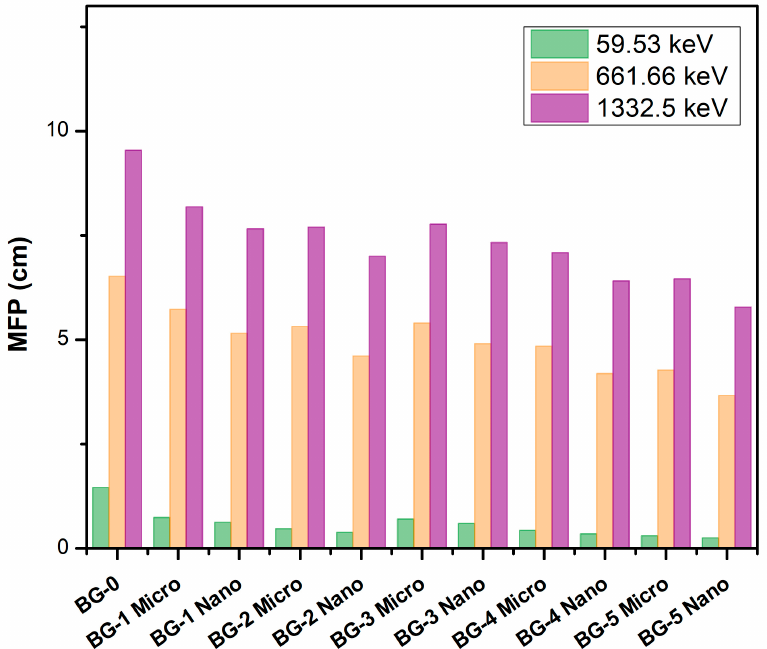
Figure 6. The mean free path of the Bi 2 O 3 /bentonite–gypsum composites at photon energies 59.53, 661.66, and 1332.5 keV.